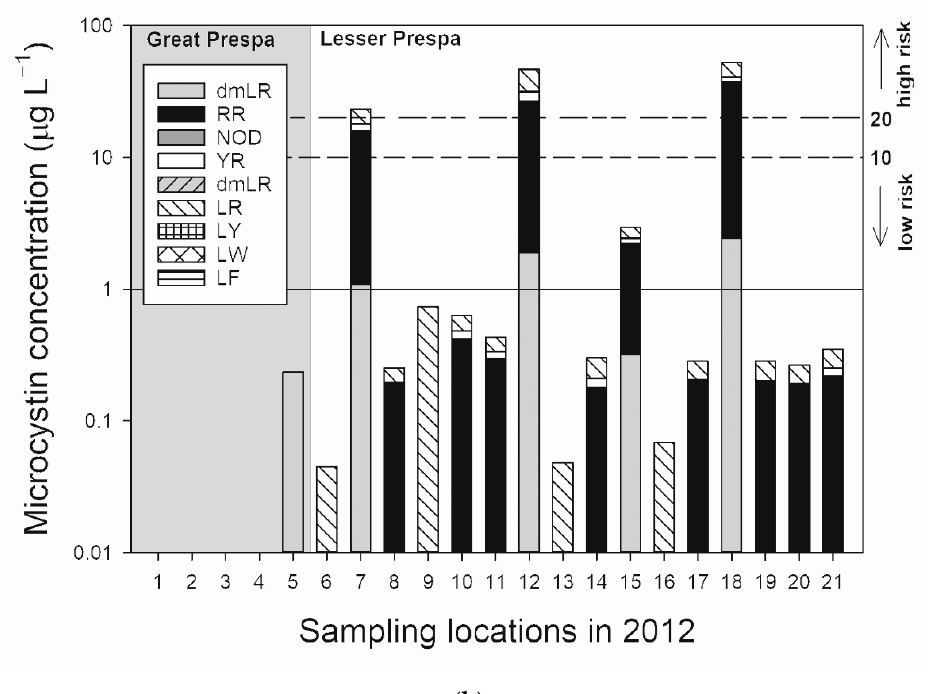
Figure 2. Concentrations ( μ g L − 1 ) of different microcystin variants measured in samples collected in two nearshore locations at Lake Great Prespa (I, II) and three locations in Lesser Prespa (III,IV,V) between 3 July – 14 August 2012 (Panel a ) and in samples collected on August 30th/31st 2012 at five sites in Lake Great Prespa (1–5) and sixteen sites in Lake Lesser Prespa (6–21) (Panel b ). The dashed lines indicate levels below or above which the health risk associated with recreational activities may be low or high [41]. MC-variants LY, LW, LF and nodularin (NOD) were not detected.